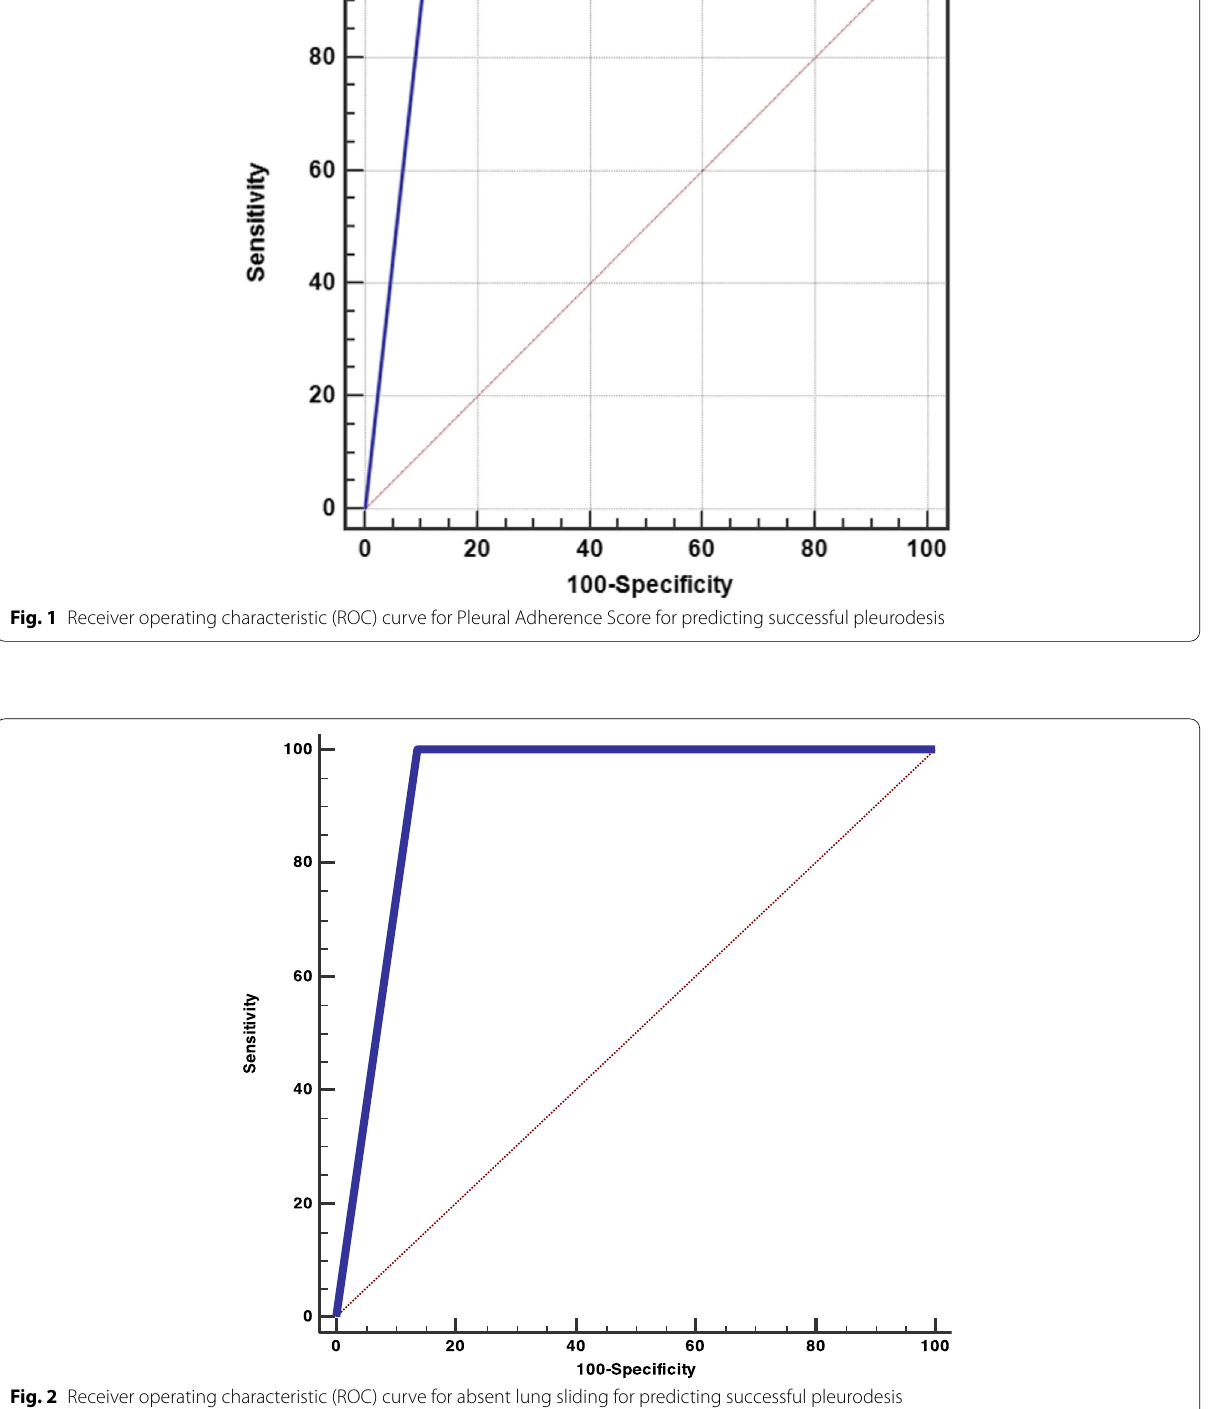
Fig. 2 Receiver operating characteristic (ROC) curve for absent lung sliding for predicting successful